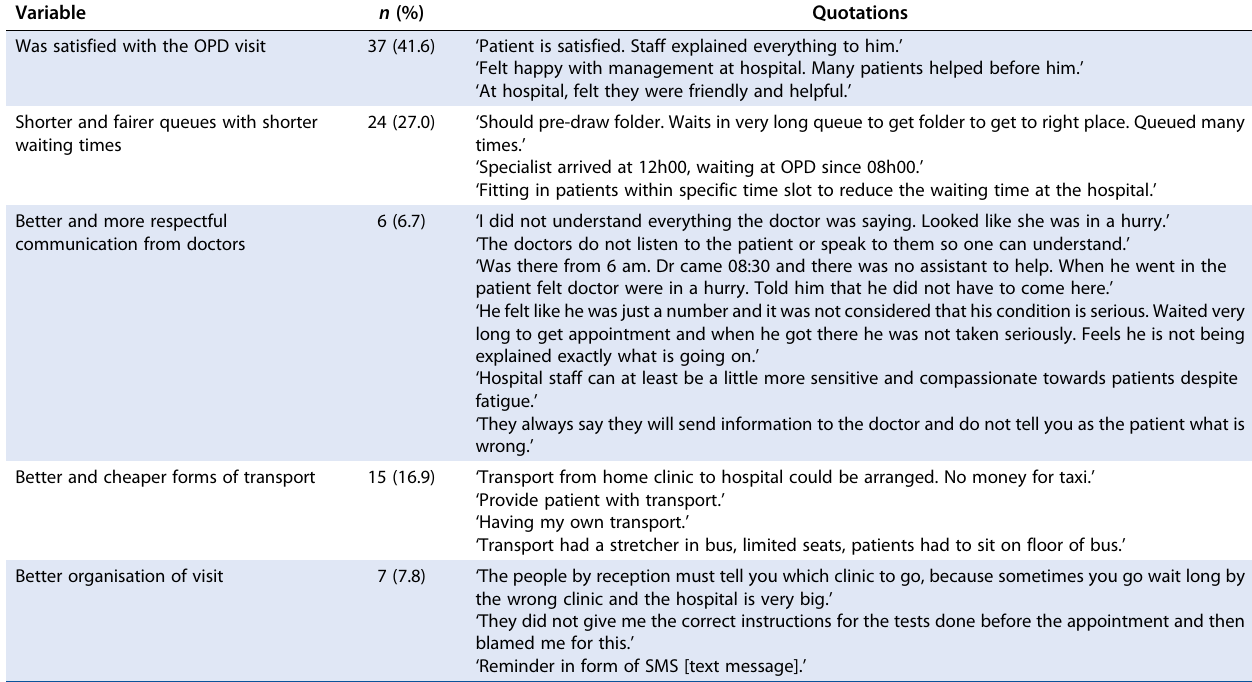
Table 7: Patients ’ feedback on their visit to OPD at the referral hospital ( n = 89) Variable n (%) Quotations Was satisfied with the OPD visit 37 (41.6)